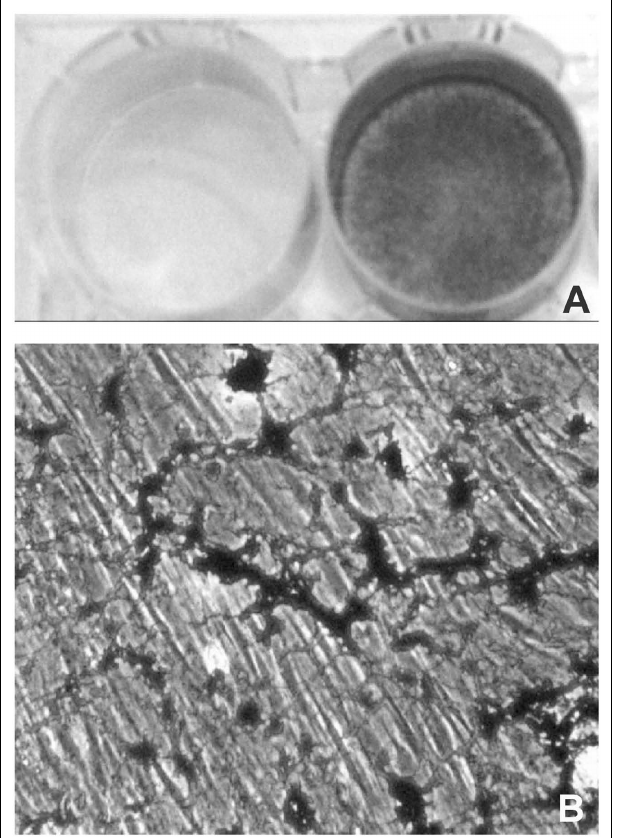
FIGURE 3 | Light microscopy of dermal fibroblasts cultured for 3 weeks in the presence of DMEM (A) or of DMEM supplemented with ascorbate, beta-glycerophosphate, and dexamethasone (B). In the presence of the calcified medium, dermal fibroblasts exhibit areas of mineralization that can be clearly visualized uponVon Kossa staining as dark deposits (lower panel; see also Boraldi etal., in press, for methodological